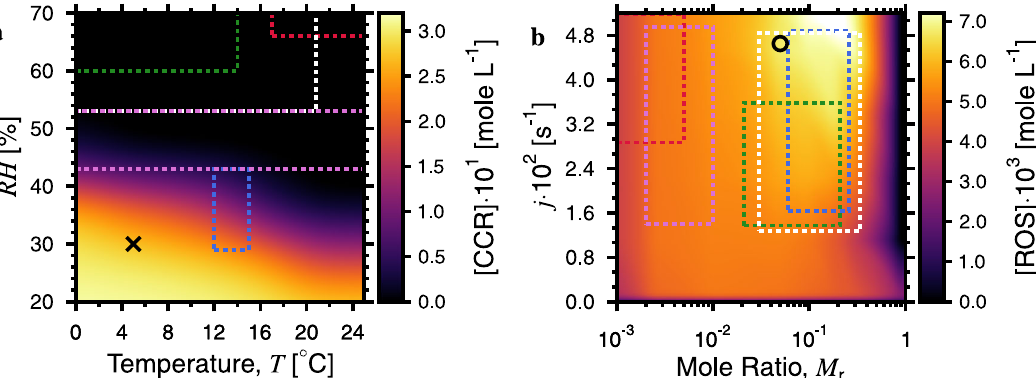
Fig. 3 Microphysical control on predicting quasi-steady state carbon centered radicals (CCR) and reactive oxygen species (ROS) concentration in the atmosphere. a CCR concentration, [CCR], as a function of temperature, T , and relative humidity, RH , in particles is shown. High [CCR] occurred primarily at drier conditions and lower T to a lesser degree. b ROS concentration, [ROS], as a function of the mole ratio between iron(III)-citrate (Fe III Cit) and citric acid, M r , and the photochemical reaction rate, j . The maximum ordinate value, j = 5.23 × 10 -2 s -1 , corresponds to the photochemical dissociation rate for Fe III Cit with a light intensity at the Earth ’ s surface at 0° zenith. M r and j values in a are indicated by the circle in b . T and RH values in b are indicated by the cross in a . [CCR] and [ROS] were averaged over the last 30 min for a particle having a radius of 0.5 µ m in a 1 h simulation using the photochemical reaction and diffusion (PRAD) model. Dashed colored rectangles indicate the range of values for various fi eld studies held in the southern Great Plains, USA 17 (purple), Aksu, China 19 (blue), urban centers in Canada 20 (white), the Po Valley of Italy 21 (green), and Okinawa Island 39 (red) detailed in the Supplementary